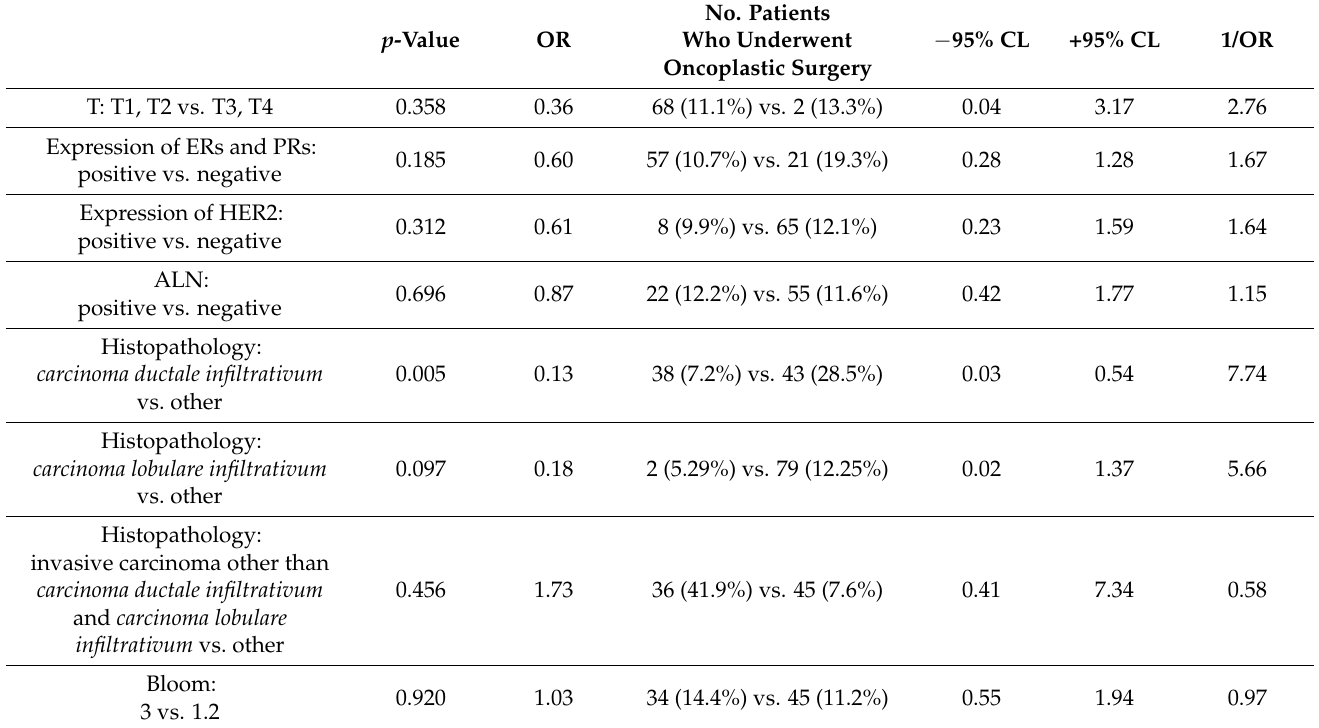
Table 4. The multivariate regression analysis on the performed oncoplastic surgery and the clinical features of the breast carcinoma. No. Patients p -Value